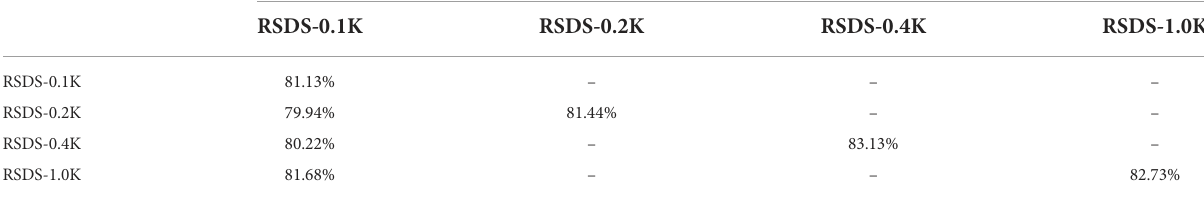
TABLE 5 Test accuracy comparison.